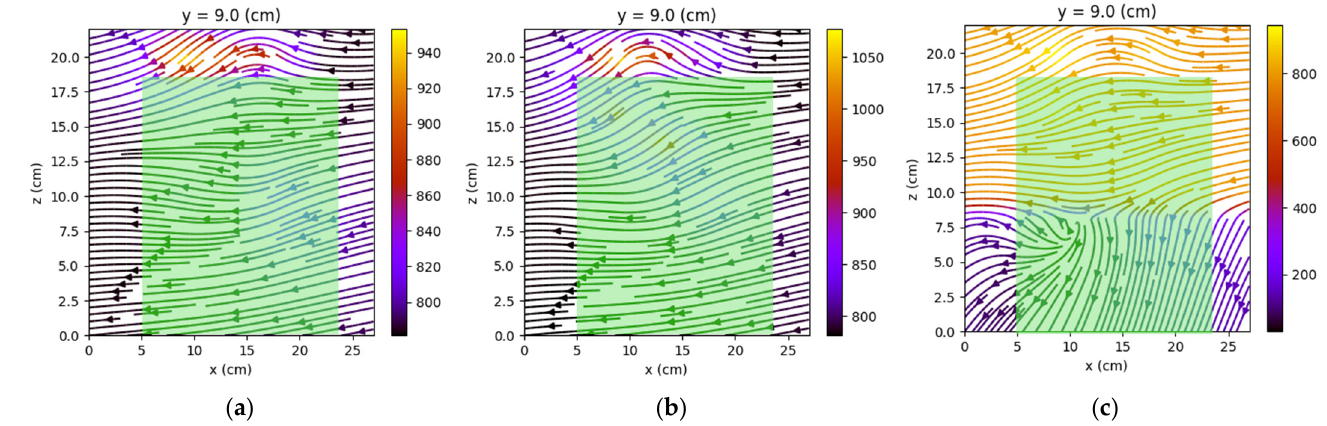
Figure 21. The shape of the field lines for the three possibilities of picked relay: C1-3 ( a ), C2-4 ( b ), and both coils ( c ). The green area represents the measured relay.